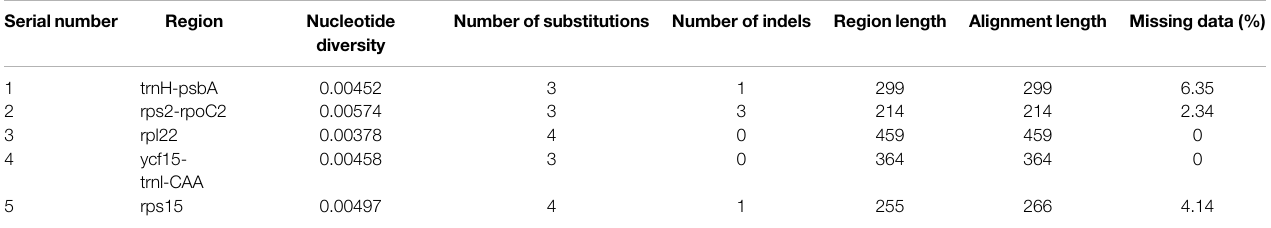
Abbreviation: Indels, insertions/deletions. Note: The “ Region length ” data of each gene was obtained from the “ C. bungei ” reference sequence.